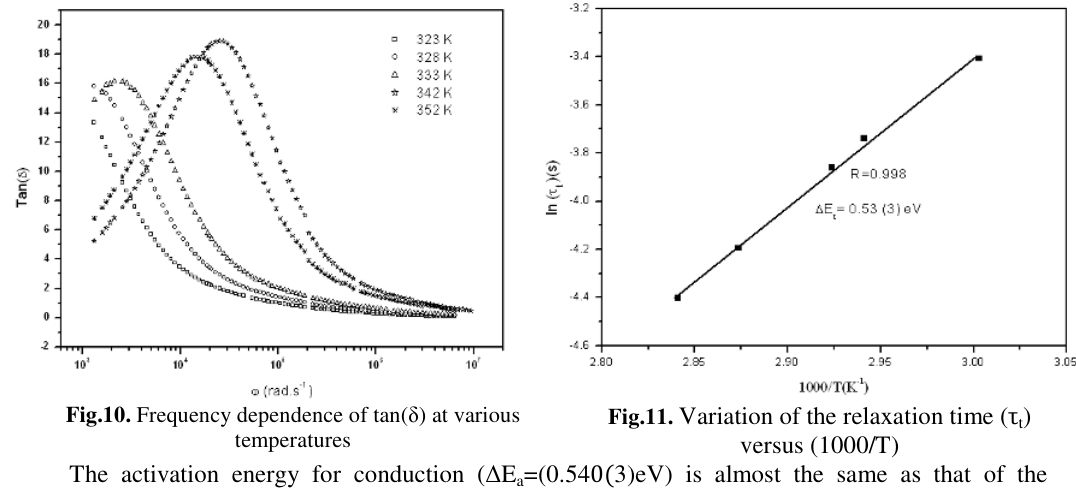
Fig.11. Variation of the relaxation time ( τ t ) versus